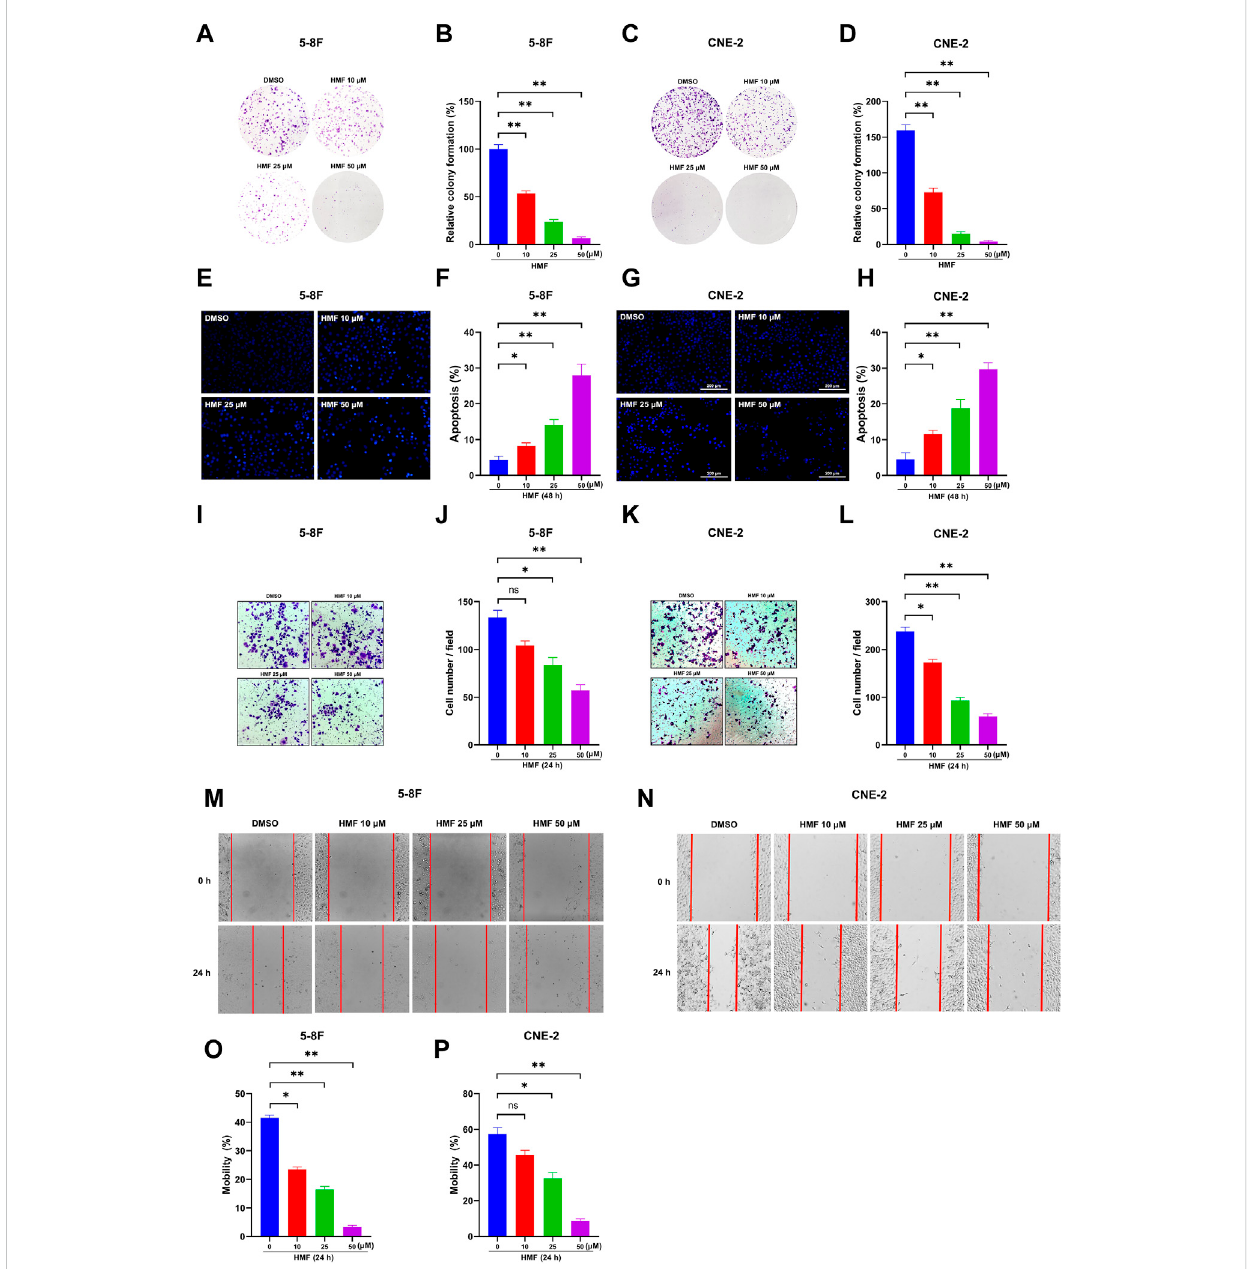
structure for > 24 h. The tumor tissues were then embedded in paraf fi n, cut into slices (8 μ m), and stained with H&E. The stained slices were scanned under a light microscope (Olympus, Japan) to evaluate tumor